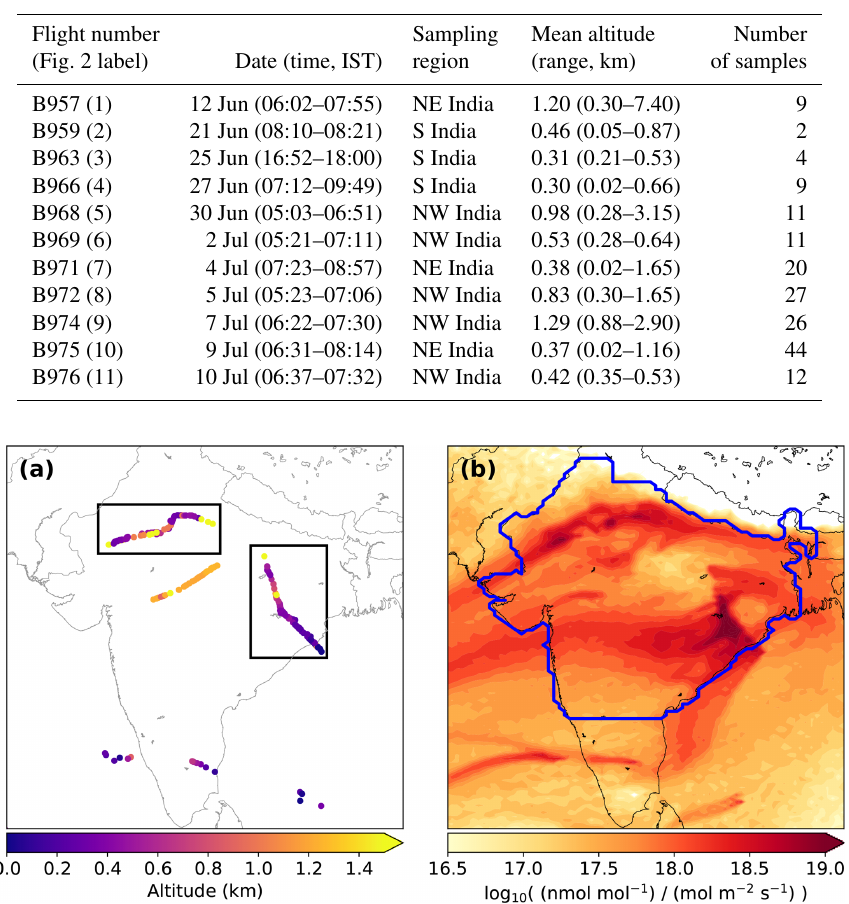
Table 2. Aircraft campaign flight summary statistics. IST: Indian Standard Time.